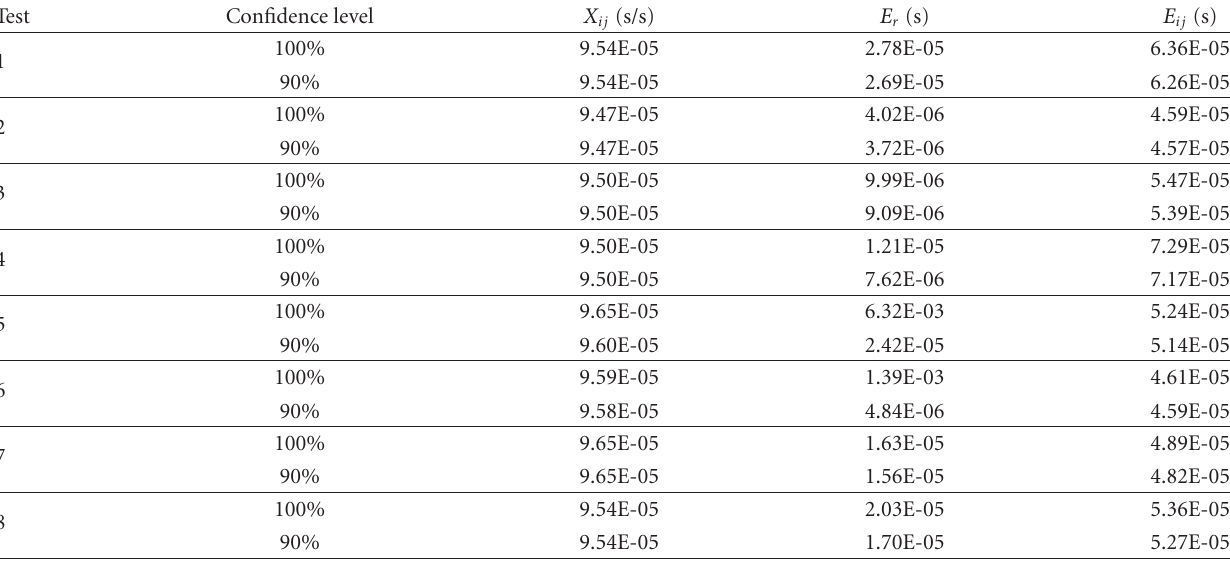
Table 6: Clock drift approximation according to several di ff erent